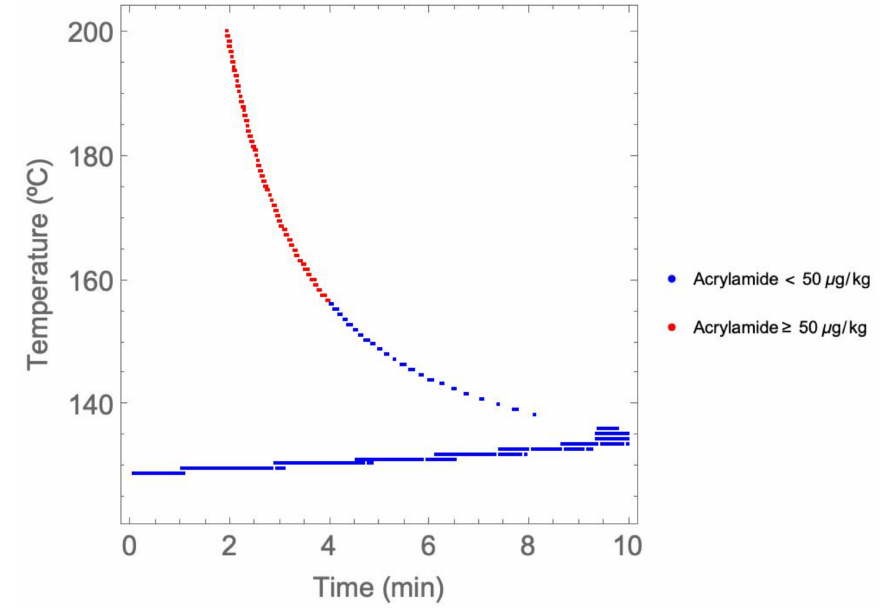
Figure 3. Pareto front temperature–time